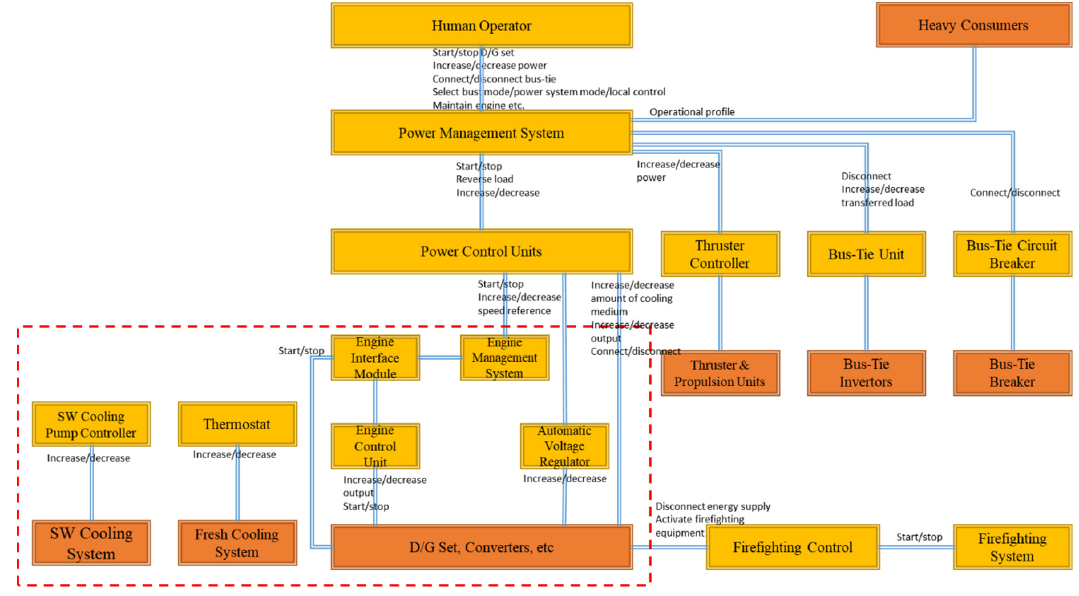
Figure 5. System diagram of engine power plant.